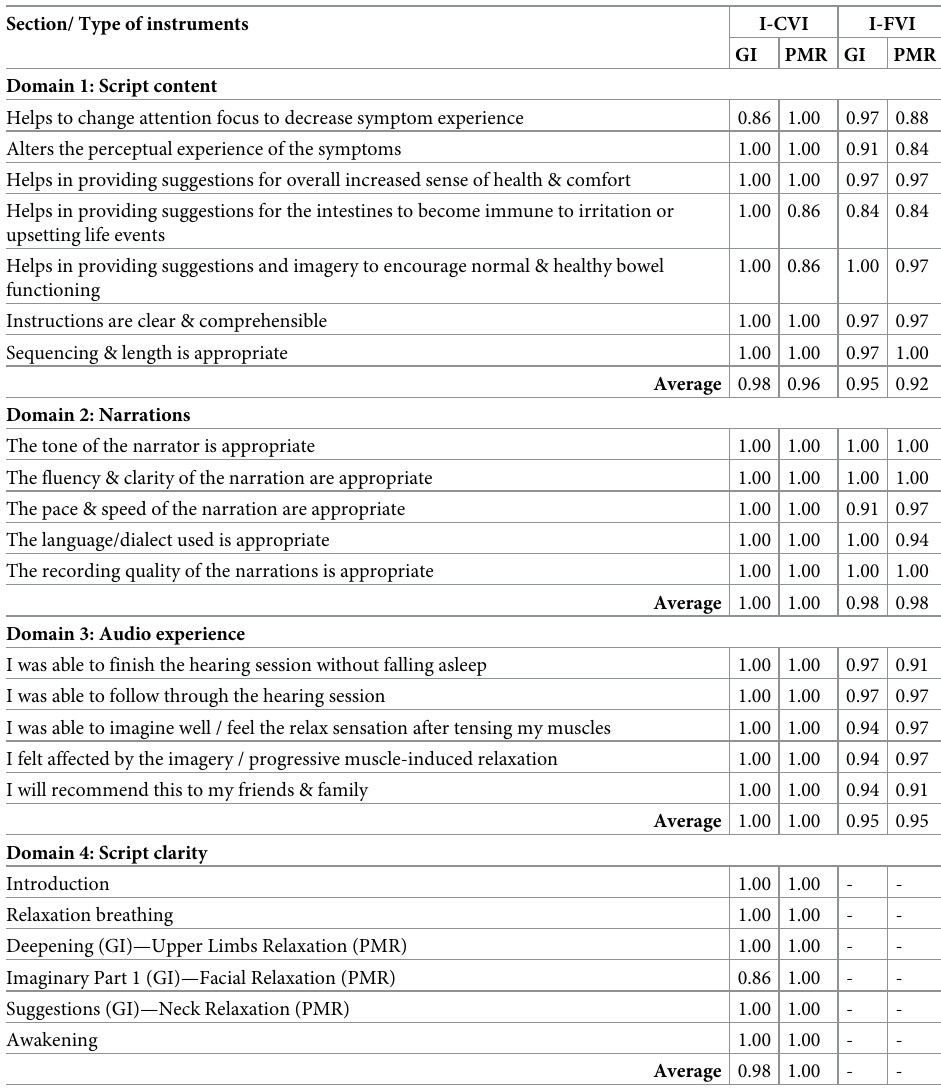
Table 2. Content and face validity of audio